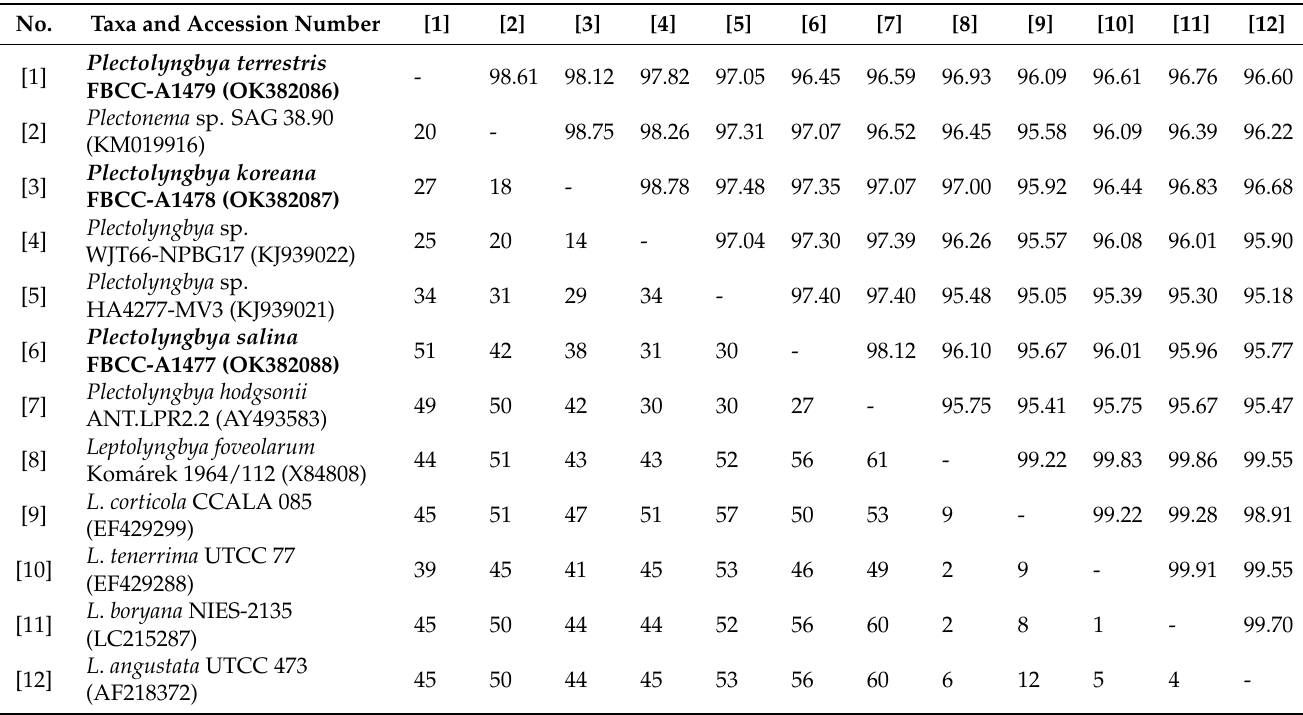
Table 1. The similarity (upper diagonal, %) and absolute difference (lower diagonal, base pairs) matrix of 16S rRNA among the Plectolyngbya and Leptolyngbya